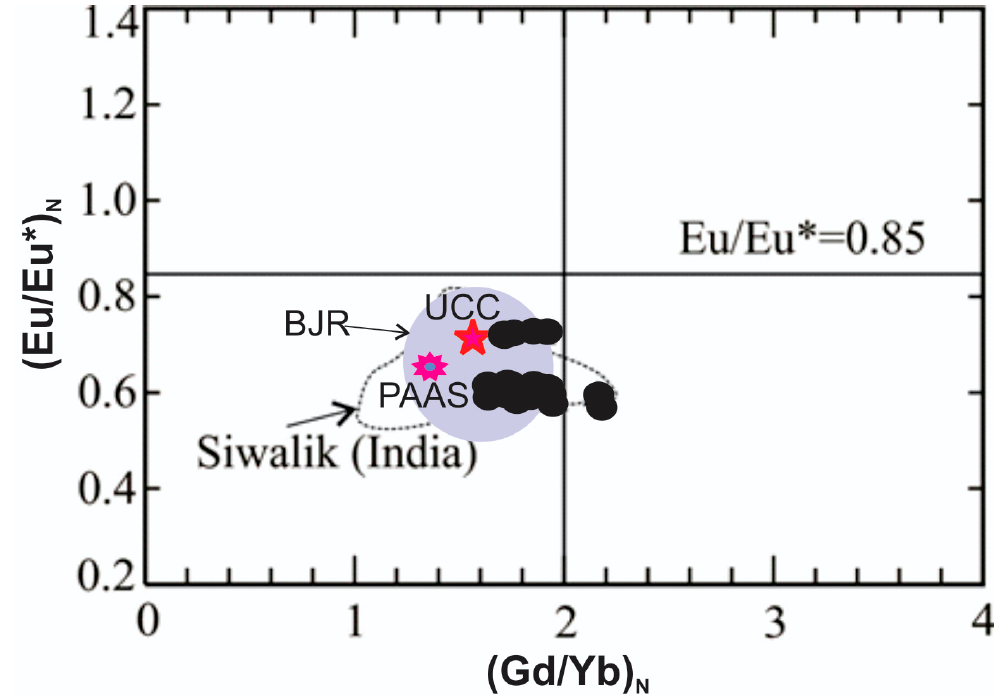
Figure 12. (Gd / Yb) N versus (Eu / Eu*) N plot [56] for the Brahmaputra River sediments. Fields for the Siwalik Group, India [39] and the Brahmaputra-Jamuna River (BJR—shaded region) from Bhuiyan et al. [7] are shown for comparison. Brahmaputra River sediment samples are represented by the black dots.